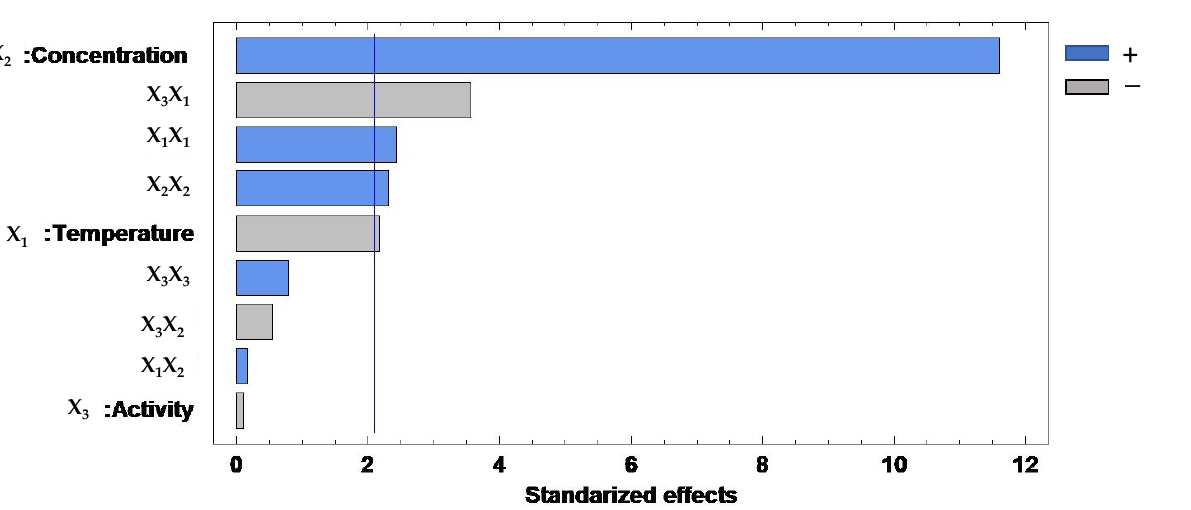
: temperature; x : concentration 1 2